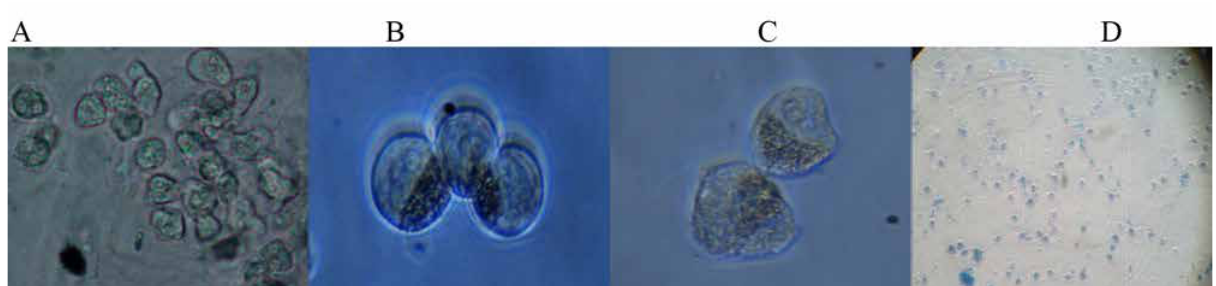
Figure 2: Micrographs of isolated rat pancreatic acinar cells at different time points (Trypan blue staining). 1A: 5 min (×200); 1B: 3 h (×400); 1C: 24 h (×400); 1D: 5 d